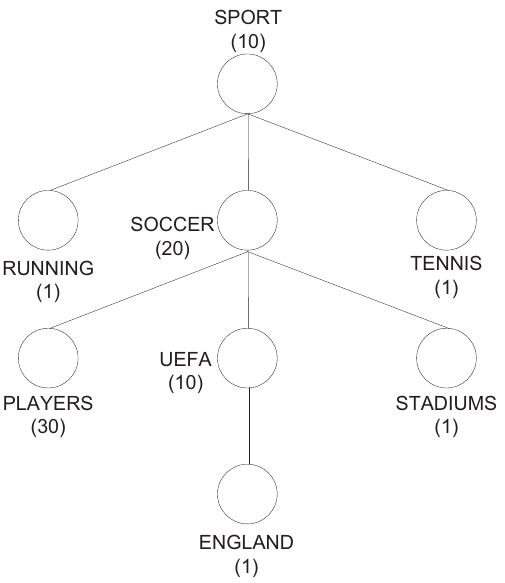
Figure 1. A simple example of an ontological user